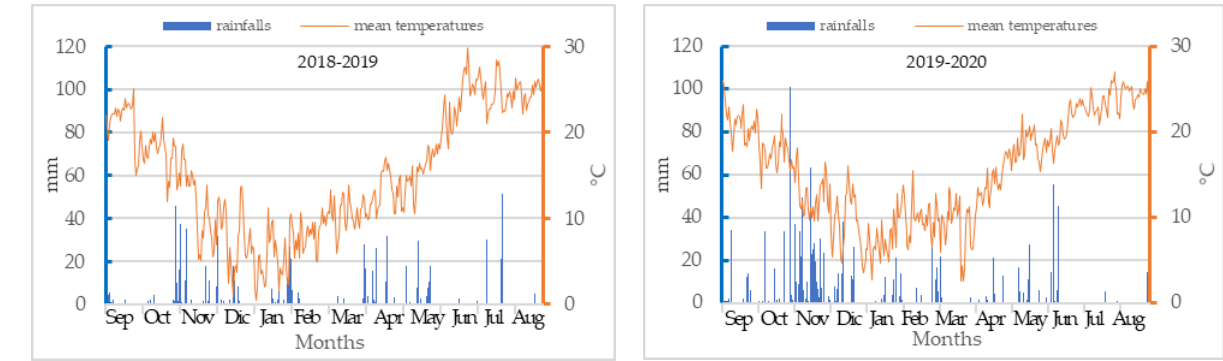
Figure 1. Rainfall (mm) and mean temperatures (°C) during the experimental period: 2018–2019 and 2019–2020.